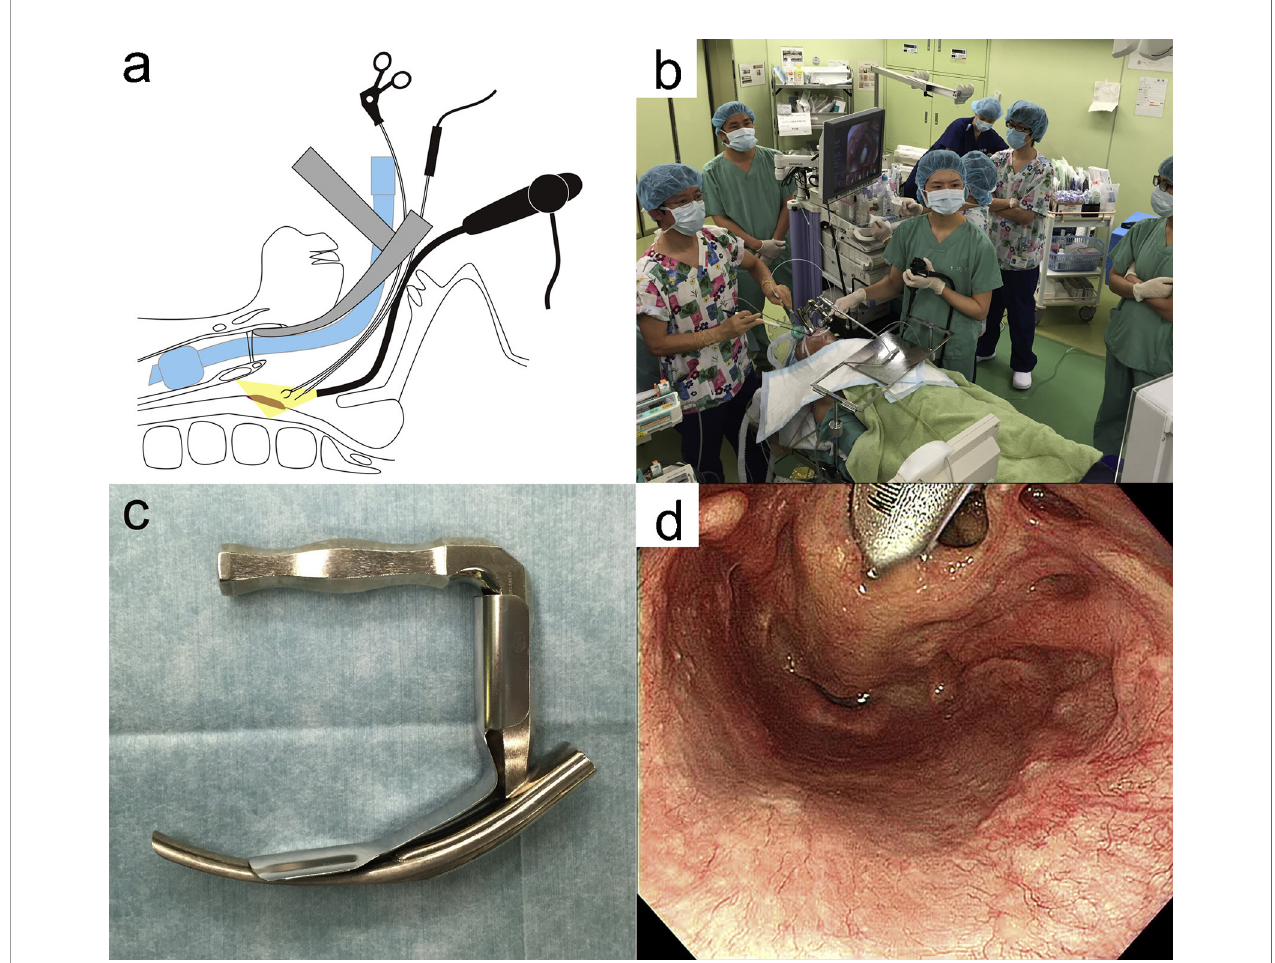
FIGURE 2 | (A) Shema of endoscopic laryngo-pharyngeal surgery (ELPS). (B) Surgical setup of ELPS. (C) Rigid curved larygo-pharyngoscope (Nagashima Medical Instruments, Tokyo, Japan). (D) Surgical view of ELPS by the rigid curved larygo-pharyngoscope. Used with permission from